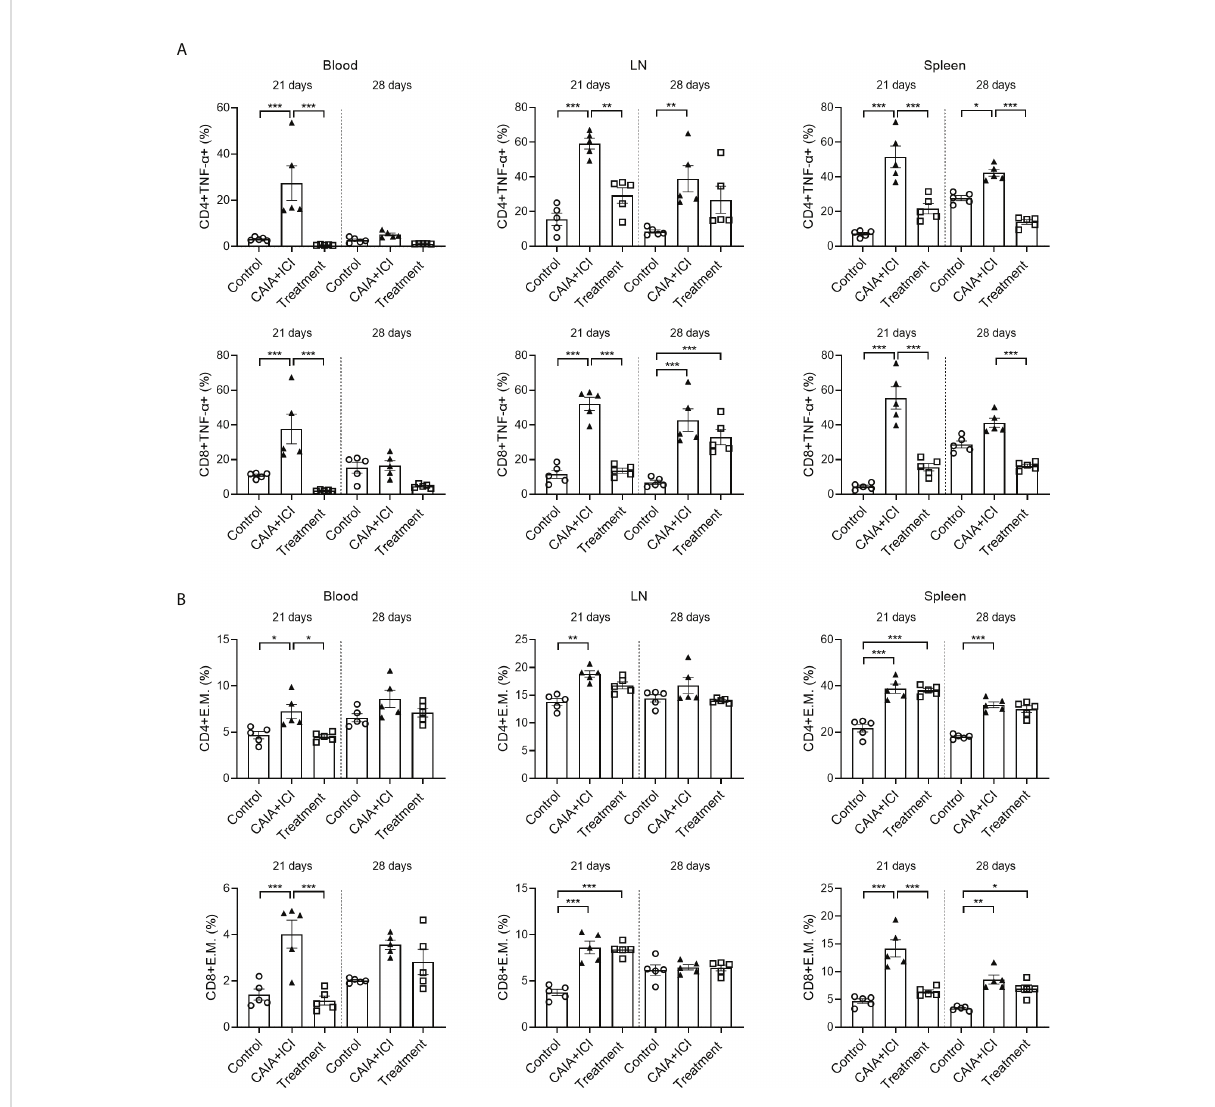
FIGURE 5 Anti-TNF- a treatment mitigates the frequency of TNF- a secreting T and effector memory T cells in mice. (A) Quantitative analyses of the frequency of TNF- a + CD4 + (top) and TNF- a + CD8 + (bottom) T cells in the peripheral blood, lymph nodes and spleens of individual mice. (B) Quantitative analyses of the frequency of CD44 + CD62L - CD4 + (top) and CD44 + CD62L - CD8 + (bottom) T cells in the peripheral blood, lymph nodes and spleens of individual mice. Data are presented as means ± SEM of each group (n=6) of mice. Statistical signi fi cance was analyzed by one-way ANOVA and post hoc Bonferroni test. * p < 0.05, ** p < 0.01, *** p <